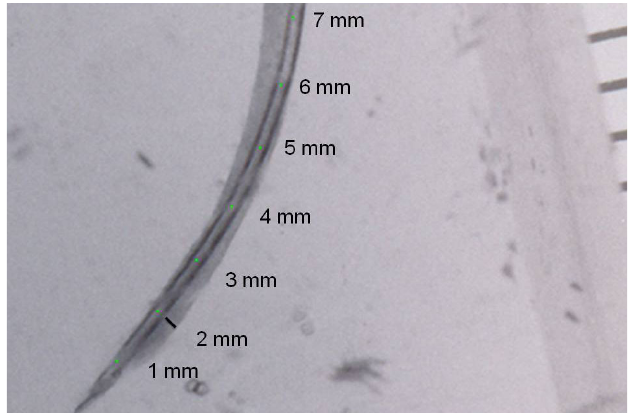
Fig. 1. Superimposed pre- and post-instrumentation images at 2 mm